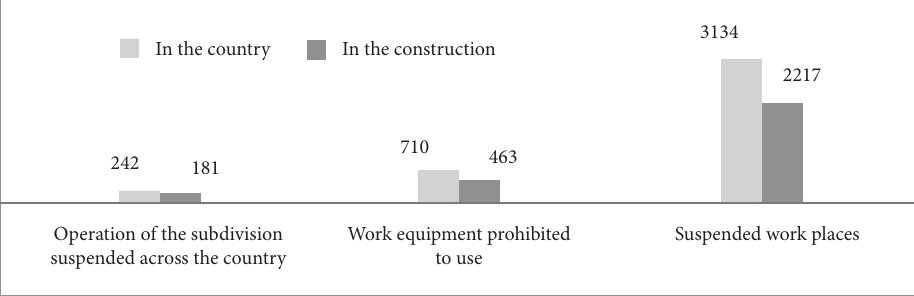
Fig. 4. Indices of violations in work organization and technical violations in construction in 2007